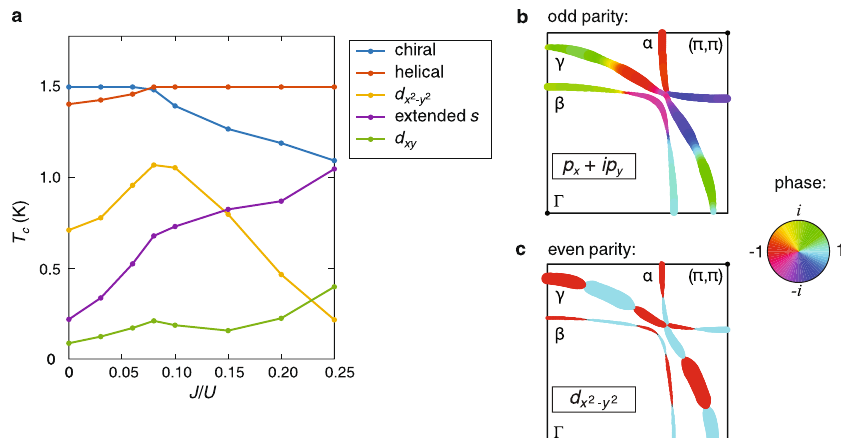
Fig. 1 a T c calculated for a variety of candidate odd parity (chiral and helical) and even parity states in Sr 2 RuO 4 , using the model of ref. 33 with the maximum calculated value normalised to the experimentally observed 1.5 K. The details clearly have a strong dependence on the model and its underlying assumptions; the data are shown only to illustrate the main point, namely that many different order parameters are close to being degenerate in Sr 2 RuO 4 . b , c The complicated gap structures predicted for illustrative odd and even order parameter candidates, calculated for J / U = 0.06 ( b , c from ref. 42 reprinted with permission from